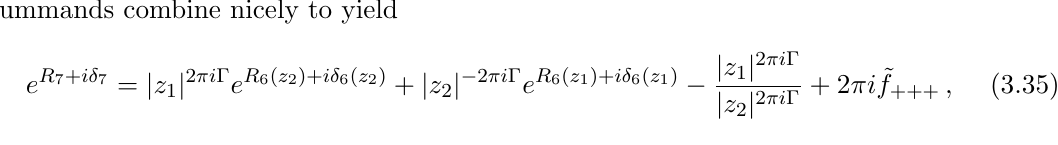
Figure 4 . The deformed integration contour for the seven-gluon BFKL integral, which is convenient for the weak coupling expansion in the region z 1 (cid:28) 1 ; z 2 (cid:29) 1. summands combine nicely to